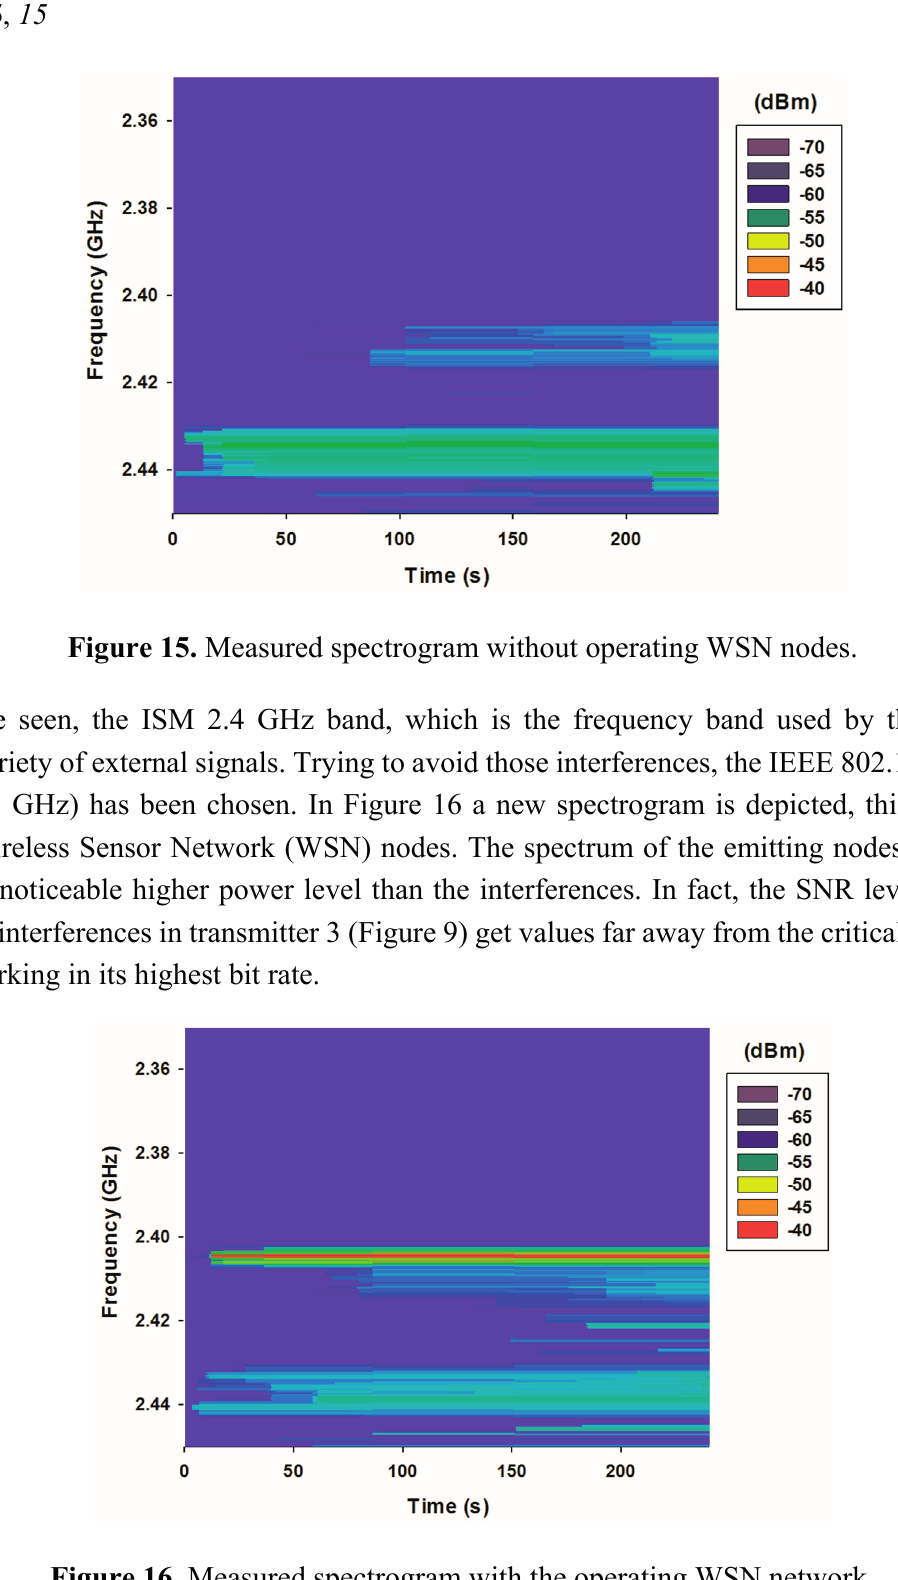
Figure 16. Measured spectrogram with the operating WSN